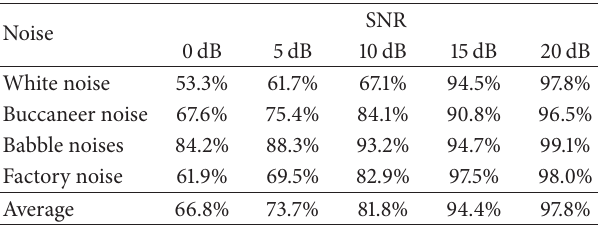
Table 2: Accuracy of the proposed VAD algorithm at different SNR